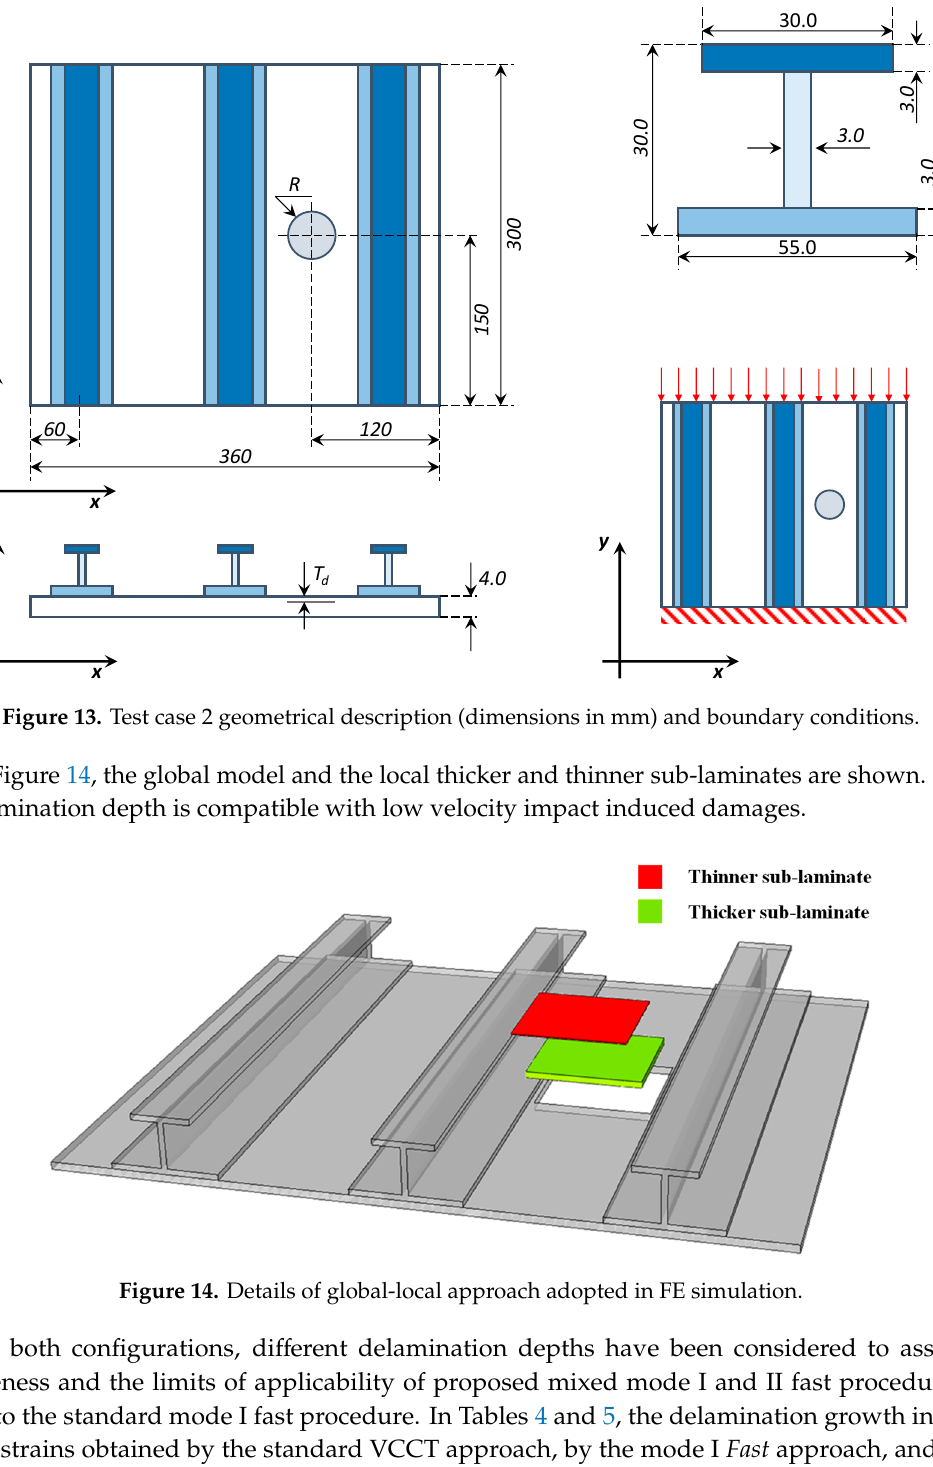
Table 4. Results summary for SS#1 damage configuration (25 mm radius delamination).